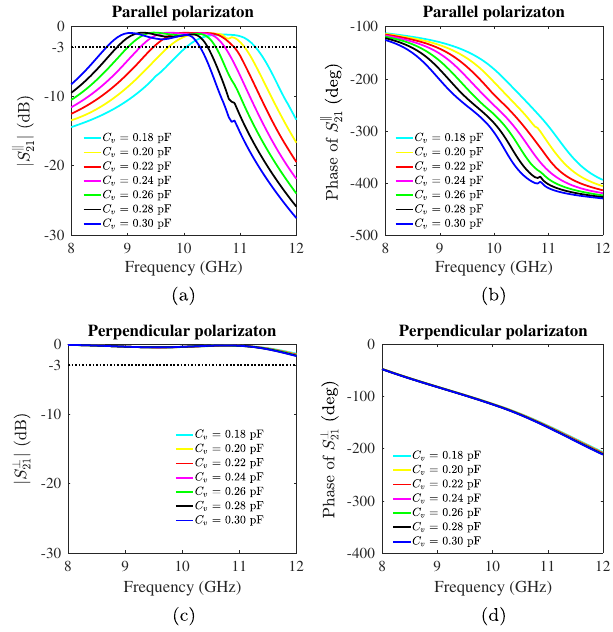
FIG. 7. Simulated transmission response of the birefringent board. (a) Transmission amplitude for the parallel polarization. (b) Transmission phase for the parallel polarization. (c) Trans- mission amplitude for the perpendicular polarization. (d) Trans- mission phase in the perpendicular polarization.